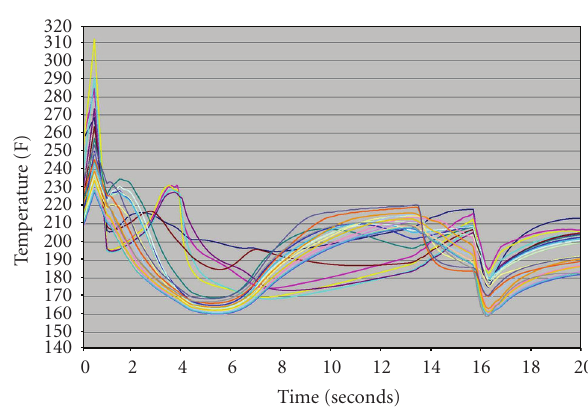
Figure 6: Example of RELAP/SCDAPSIM-calculated fuel plate centerline temperatures for the 24 fuel plates in MURR for a cold leg large break transient.